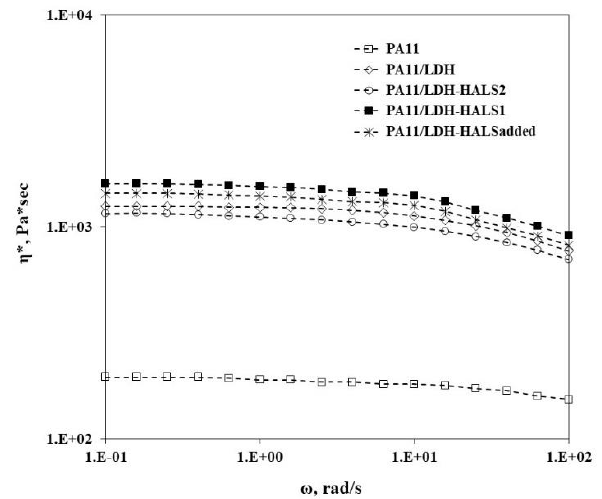
Figure 6. XRD patterns of all investigated PA11-based nanocomposites.